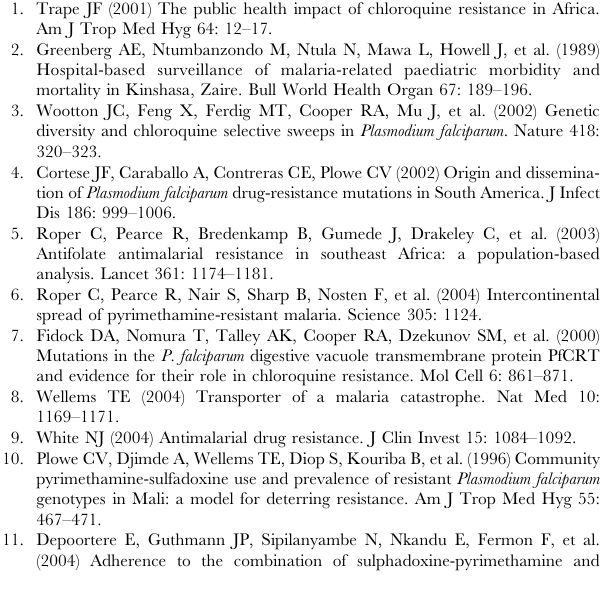
Table S1 Sequence of the primers and probes used.